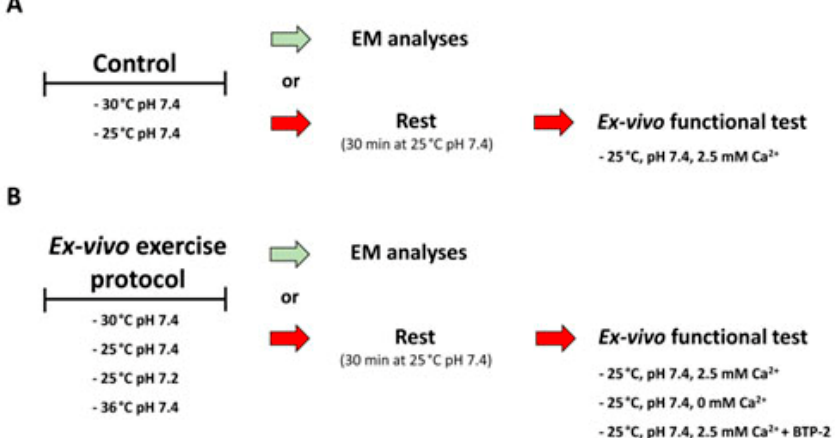
Figure 1 . Schematic representation of the ex vivo experimental procedures . ( A ) Control EDL muscles were kept at rest in KH solution for 45 min (the same duration of the ex vivo exercise protocol) and then either immediately fixed for EM analysis (green arrow) or kept in a rest condition for 30 min (25 °C, pH 7.4) and then subjected to the ex vivo functional test (red arrows). ( B ) EDL muscles exercised ex vivo were either immediately fixed for EM analysis or kept in rest condition for 30 min (25 °C, pH 7.4) and then subjected to the ex vivo functional test.